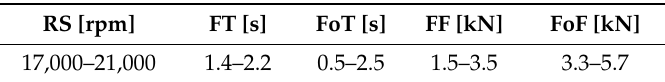
Figure 2. X-ray tomography joint formation measurements: rivet penetration depth (H); maximum width of the deformed rivet tip (W); depth until the maximum width of the rivet tip, or anchoring depth, (Dp); the height of the deformed rivet tip (B); and with original rivet diameter displayed (D).